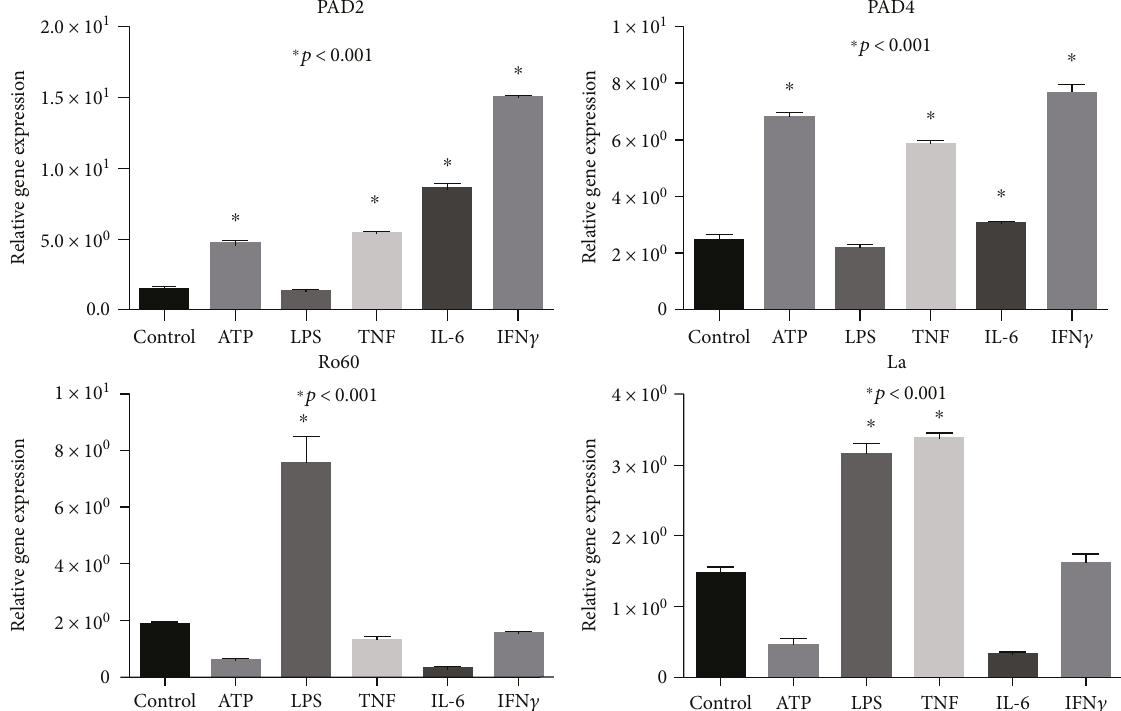
Figure 3: Di ff erential gene expression of PAD2, PAD4, Ro60, and La induced by molecular stimulants ATP, LPS, TNF, IL-6, and IFN γ by quantitative PCR (qPCR). Graphs show the validation done by the comparative method ( Δ Ct). The expression level of each gene was normalized using 18S gen as invariant endogenous control. Asterisk on the top of the bars means that induced gene expression was signi fi cantly di ff erent with a p value of < 0.0001 Student t -test.